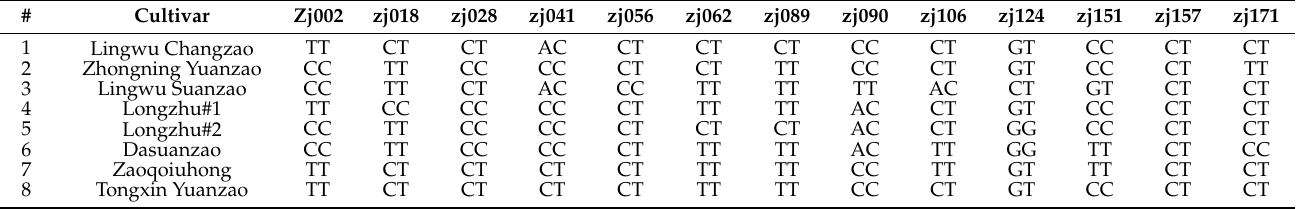
Table 4. Examples of individual fruit SNP profiles based on DNA extracted from fresh jujube fruits (showing truncated profiles). The full data for all 24 fruit samples across 96 SNPs were presented in Supplementary Table